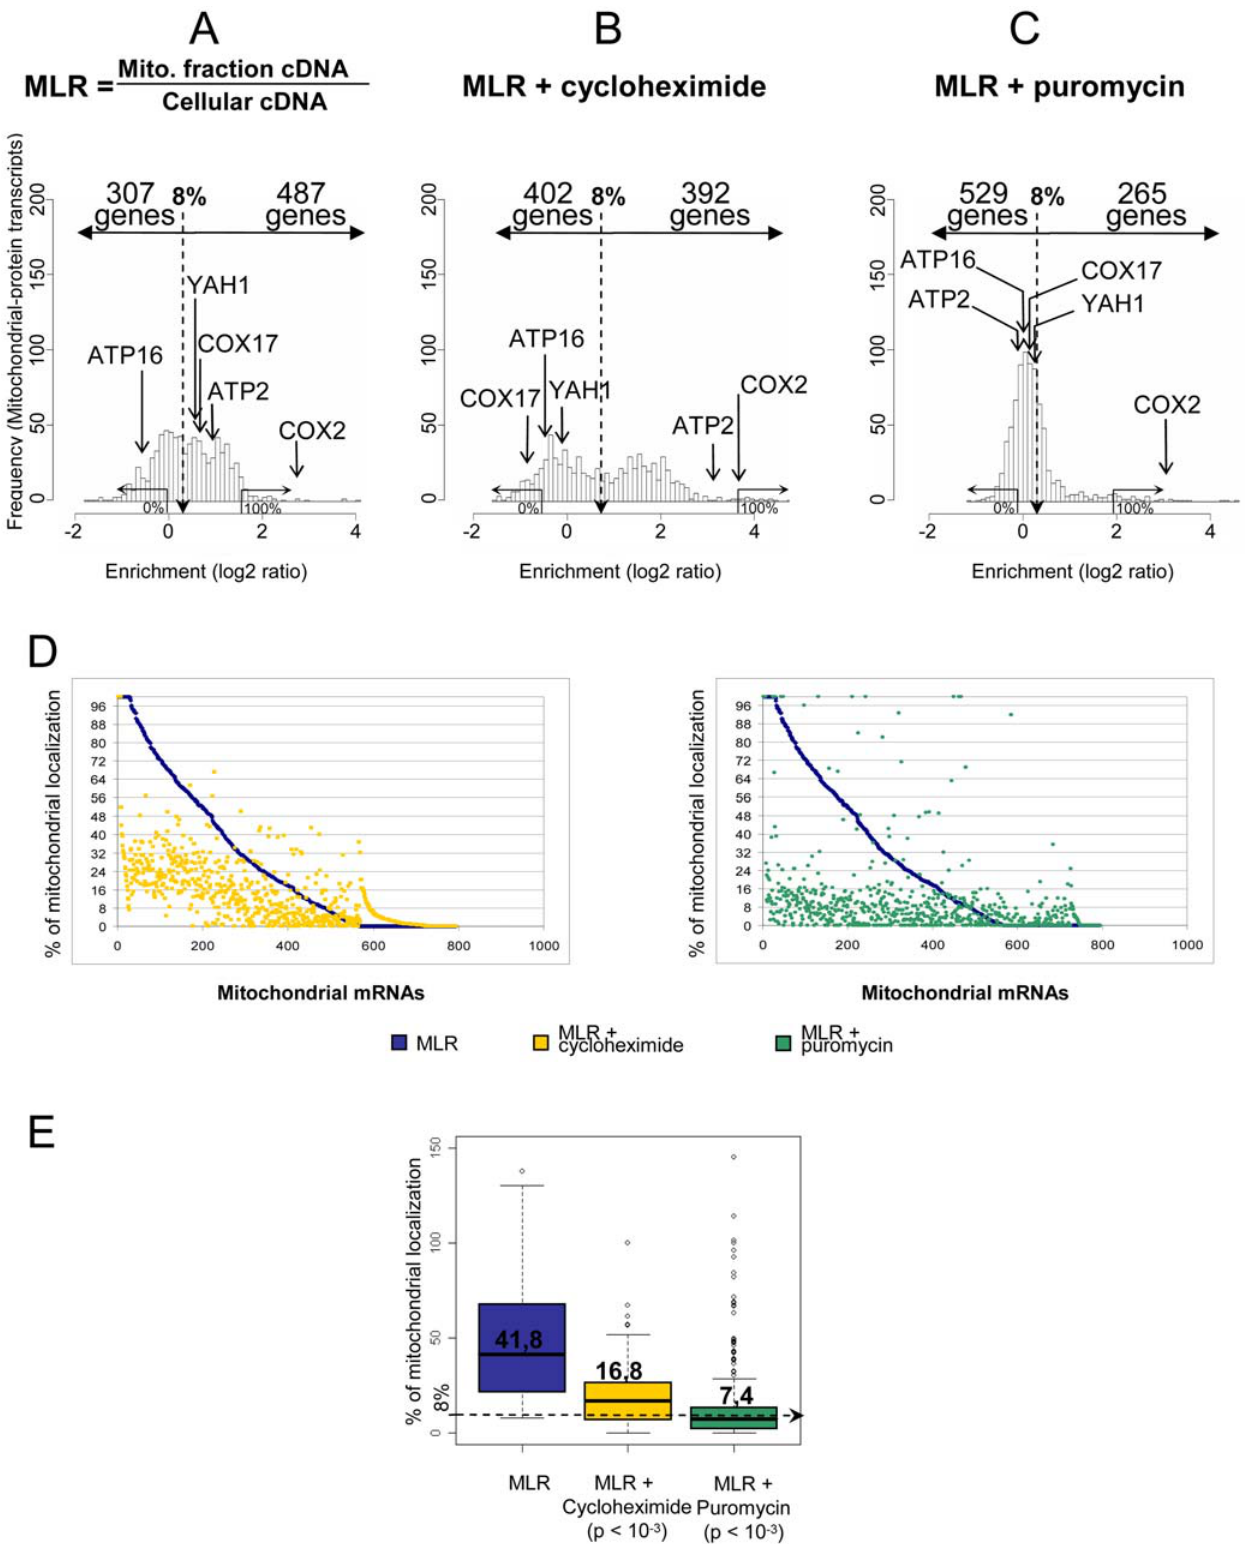
Figure 3. Effects of cycloheximide and puromycin on the asymmetric localization (MLR) of nuclear-encoded mitochondrion-linked mRNAs. The distributions focus on the 794 genes encoding mitochondrially localized proteins (A) in presence of cycloheximide (B) or puromycin (C). The threshold of 8% was determined as in figure 1. A few mRNAs are indicated as markers of different subcellular translation sites: mitochondrial mRNAs ( COX2 ), free cytoplasmic polysomes ( ATP16 ), mitochondrion-bound cytoplasmic mRNAs delocalized to free polysomes by cycloheximide ( COX17, YAH1 ), or mitochondrion-bound mRNA whose mitochondrial enrichment is increased by cycloheximide ( ATP2 ). All represent different classes